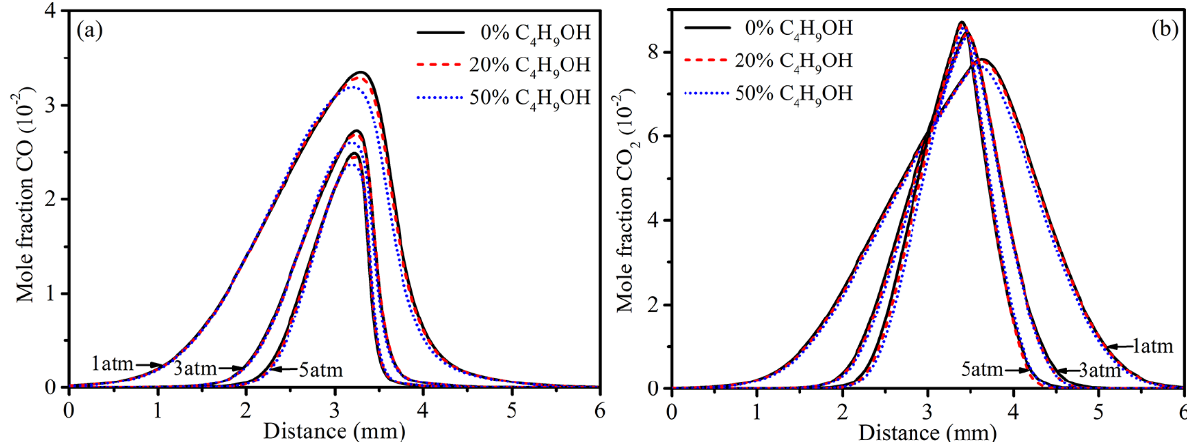
Figure 7. Mole fractions of ( a ) CO, and ( b ) CO 2 with different levels of n -butanol at different pres- sures.